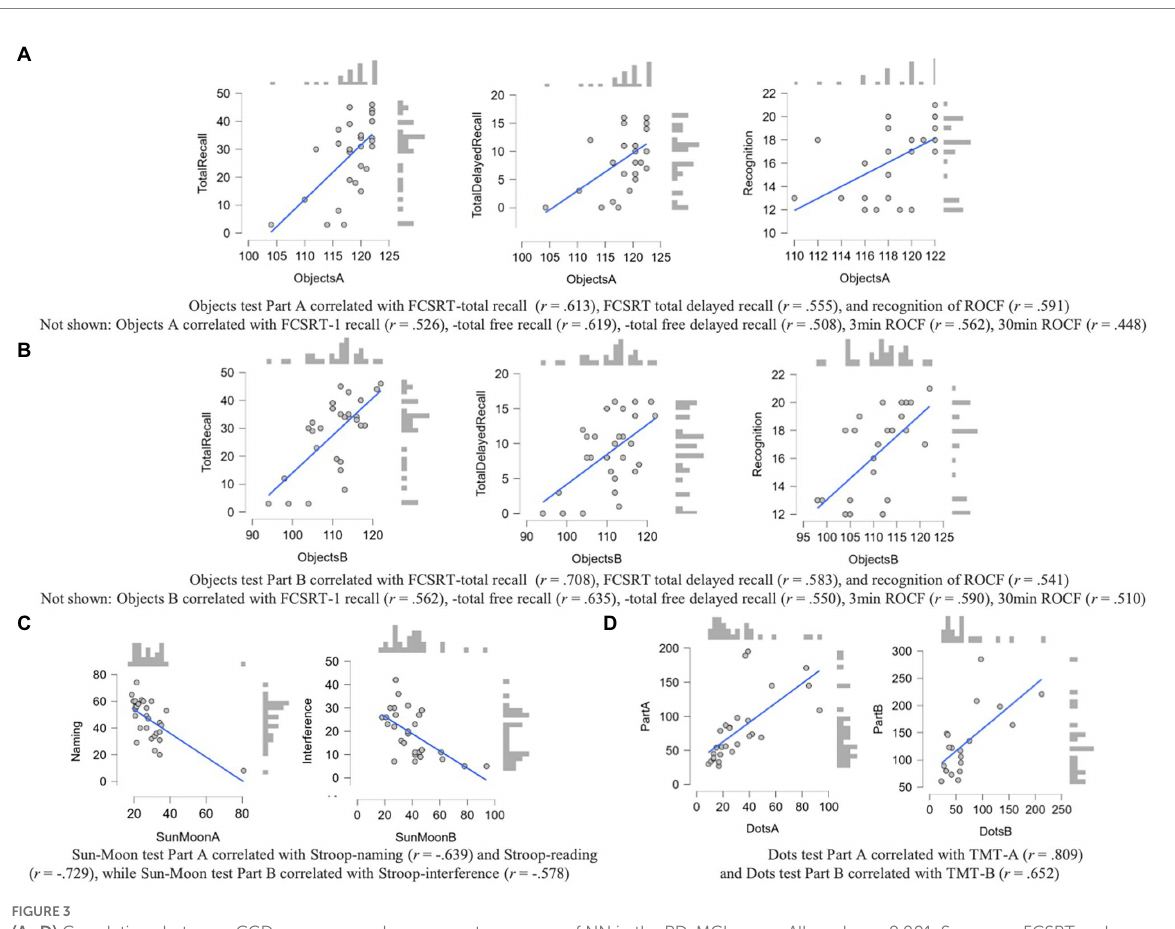
FIGURE 3 (A–D) Correlations between CCD measures and convergent measures of NN in the PD-MCI group. All p values <0.001. Scores on FCSRT and ROCF were correlated with Objects test Part A scores (A) and Objects test Part B scores (B) . Scores on Sun-Moon test Part A were correlated with Stroop – word reading scores, while Part B was associated with Stroop – interference (C) . Dots test Part A was correlated with TMT-A and Part B with TMT-B (D)